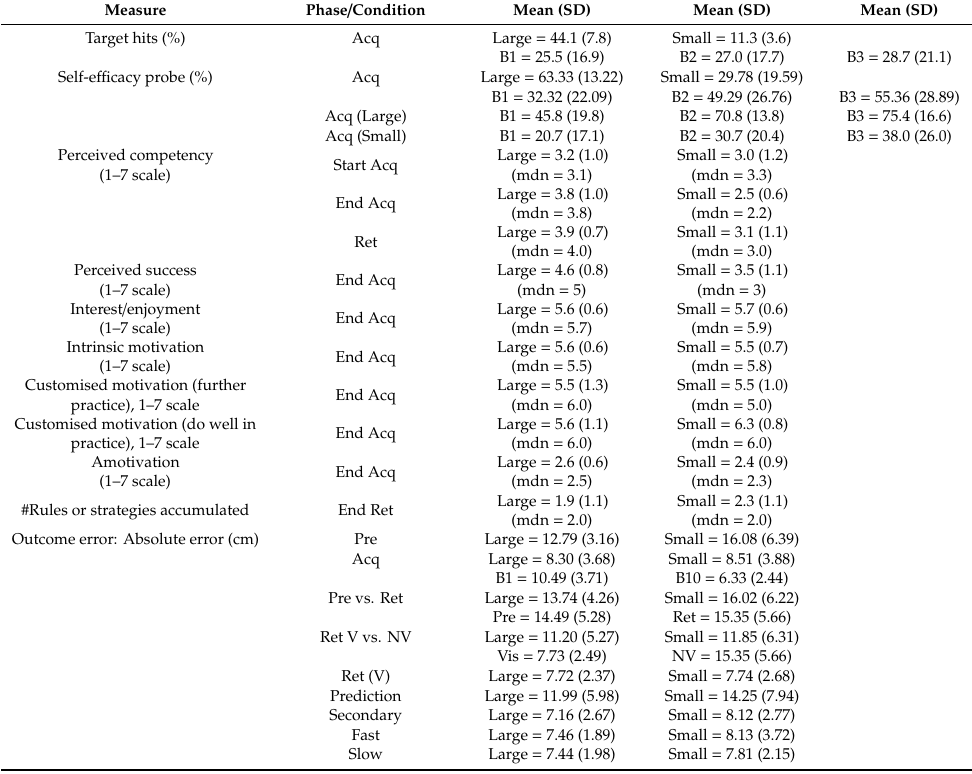
Table 2. Means and standard deviations (SDs) for all measures as well as medians (mdns) for non-parametric data associated with all main-e ff ect comparisons and statistically significant group- related post-hoc di ff